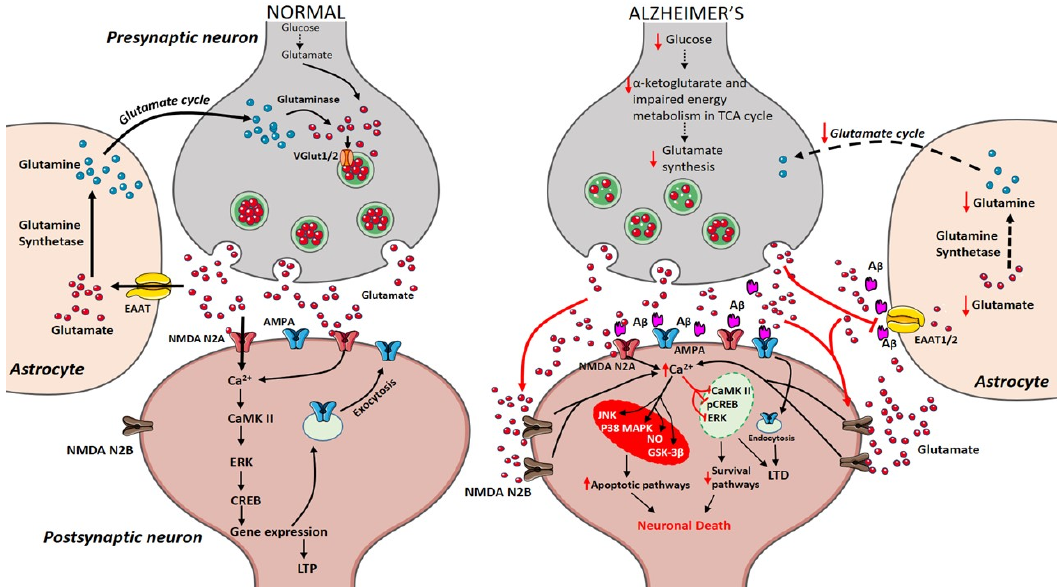
Figure 1. Presynaptic terminals release glutamate activating ionotropic receptors on postsynaptic neurons. In normal condition, N -methyl- D -aspartate (NMDA) NR2A activation induces increase in calcium levels favouring induction of long-term potentiation (LTP) through metabolic pathways (extracellular signal-related protein kinase (ERK), CaMK II, cyclic adenosine monophosphate response element-binding protein (CREB)). Excess glutamate left is taken up by astrocytes through EAAT2 converting into glutamine and glutamate by glutamine synthetase and glutaminase respectively (black arrows). The synthesized glutamate is transported into vesicles by VGlut1/2. Conversely in Alzheimer’s disease (AD), A β oligomers interfere with NMDA receptors increasing the spillover of glutamate (red arrows) to extrasynaptic sites activating NMDA NR2B receptors increasing excess calcium levels inhibiting prosurvival pathways. Imbalance in glutamate/glutamine cycle (black-dashed arrows) is also reported in the figure.